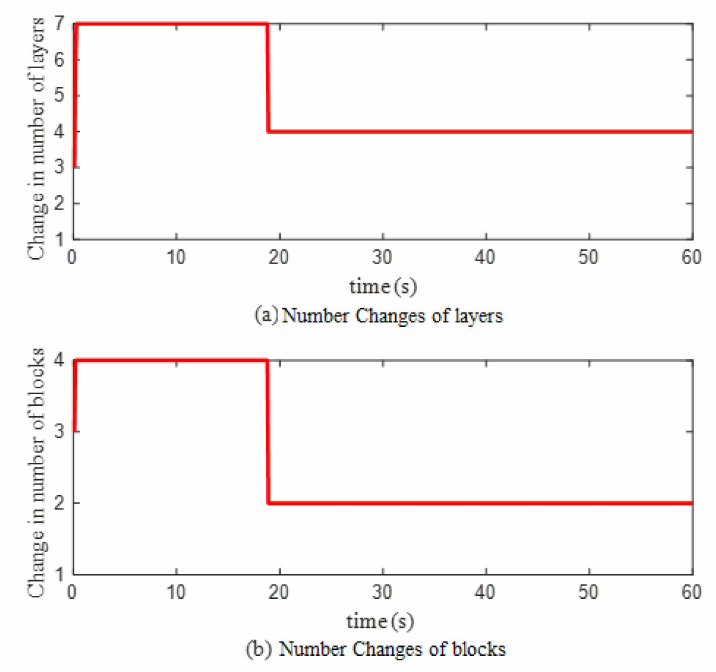
Figure 8. Changes in NSOFCMNN structure (single-cell manipulation).